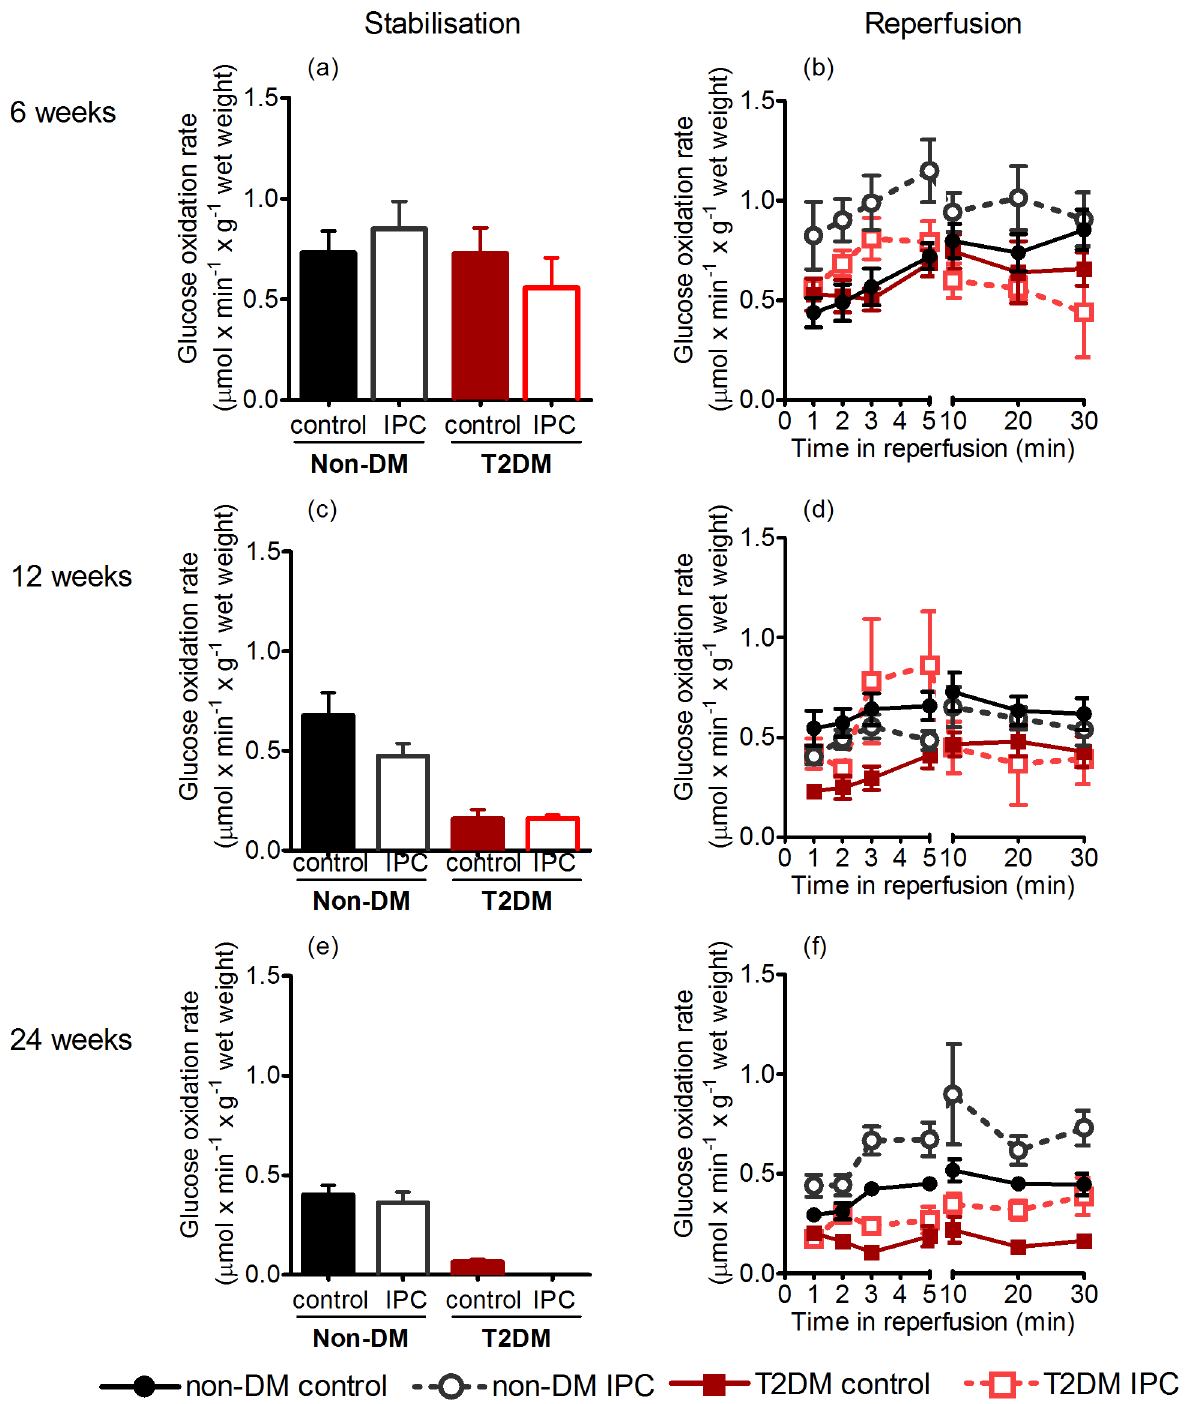
Fig 3. Glucose oxidation rates. Tracer estimated glucose oxidation rates preischemically and during stabilisation in 6- (a+b), 12- (c+d), and 2-week-old (e+f) non-DM rats (heterozygote (fa/+)) and DM ZDF rats (homozygote (fa/fa)) after control or IPC-treatment. Data are mean ± SEM (n =